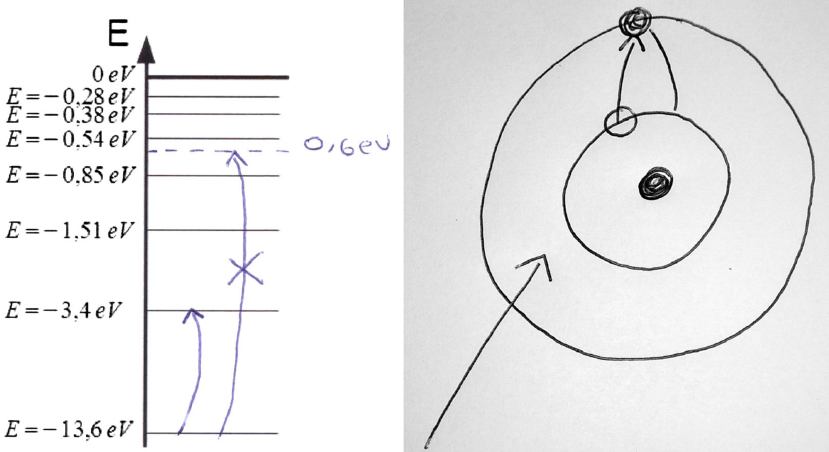
FIG. 2. Student 7 ’ s answer to Q1 (left) and representation of the atom made during the interview (right). (S)he draws a nucleus and an electron that makes a transition to a more external orbit when it absorbs a photon (represented by an arrow coming from below). (S)he uses a line to represent the transition that will result in emission of radiation. Student 7 ’ s written response: “ Subparagraph a) The atoms absorb the photons from light and they will jump to the stationary state of − 3 . 4 eV, then they will go down again emitting light. Subparagraph b) There will be no jump, it is impossible because there is no stationary state of the hydrogen atom at − 0 . 6 eV, so the photon will pass